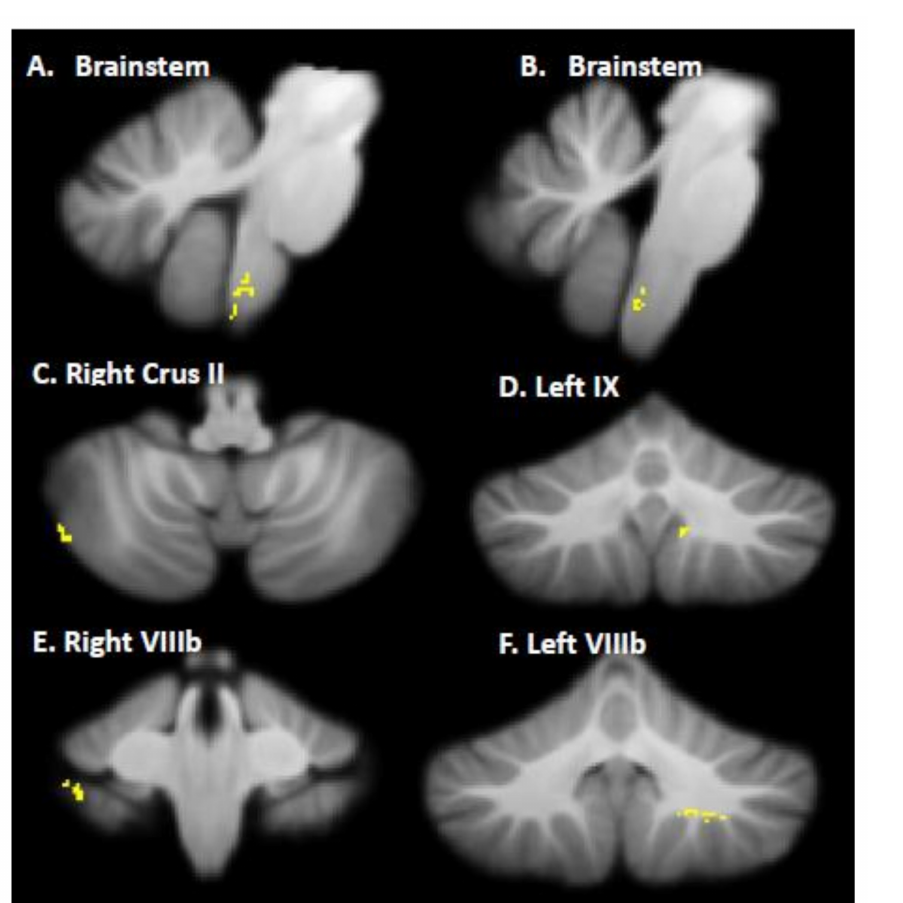
Figure 2. Increased gray matter volume in the brainstem, right crus II, left IX lobule, and bilateral VIIIb lobules after CO-OP intervention. Note: This figure corresponds to Table